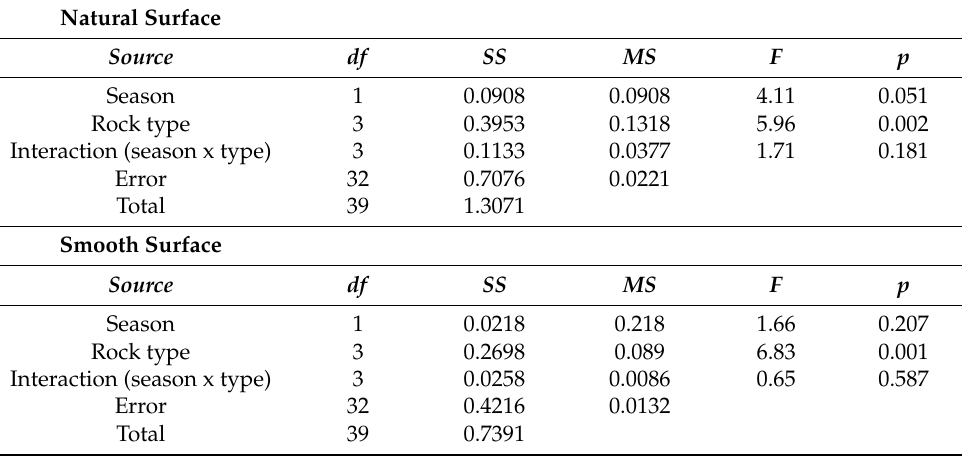
Table 2. Results of 2-way ANOVA analyzing the effect of season (summer and winter) and rock type (limestone, schist, basalt, and granite) on the mean percent survivorship of zygotes after treatment by a wave. Survivorship is calculated as a percentage based on the mean zygote density of control plates in each rock and surface type. Data were arcsine-transformed before analysis. There were 5 replicates of each rock and surface type